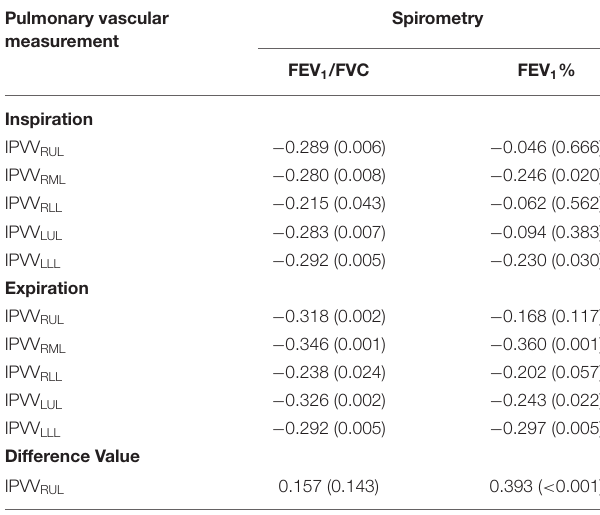
TABLE 3 | Correlation between IPVV and